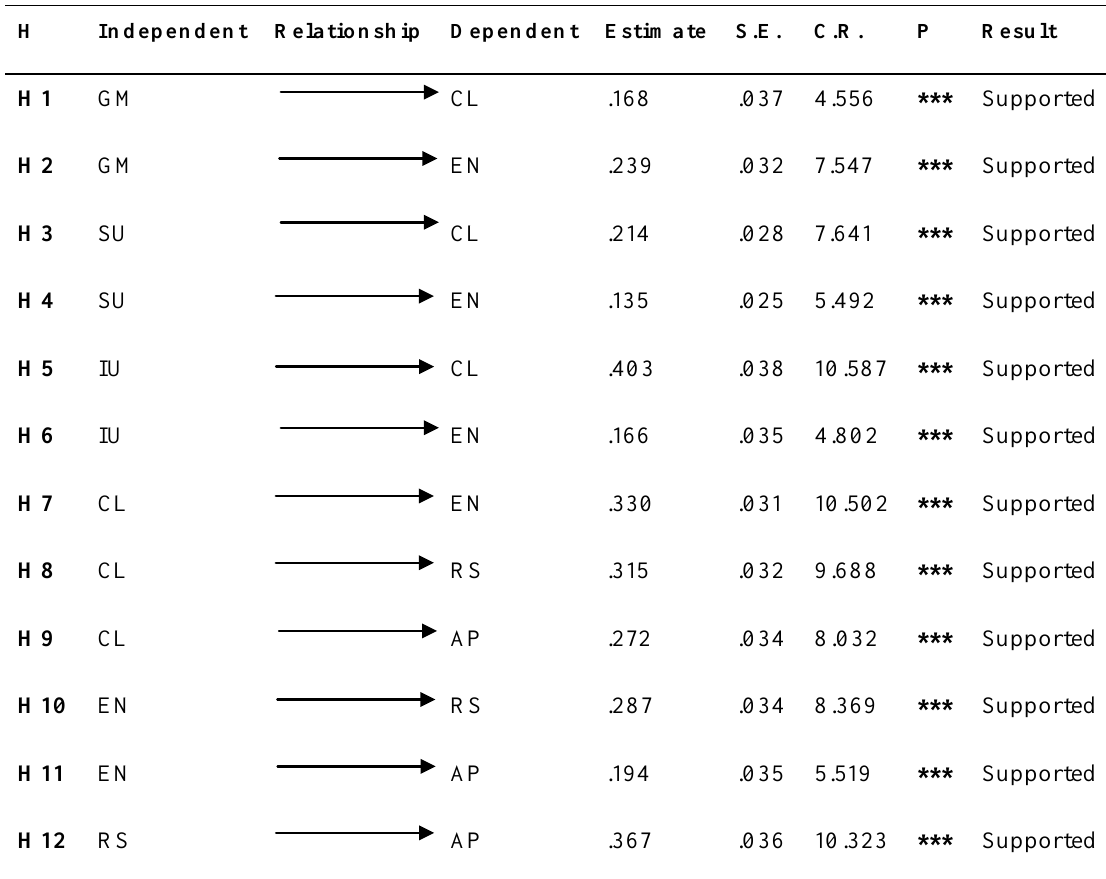
Regression Weights H Independent Relationship Dependent Estimate